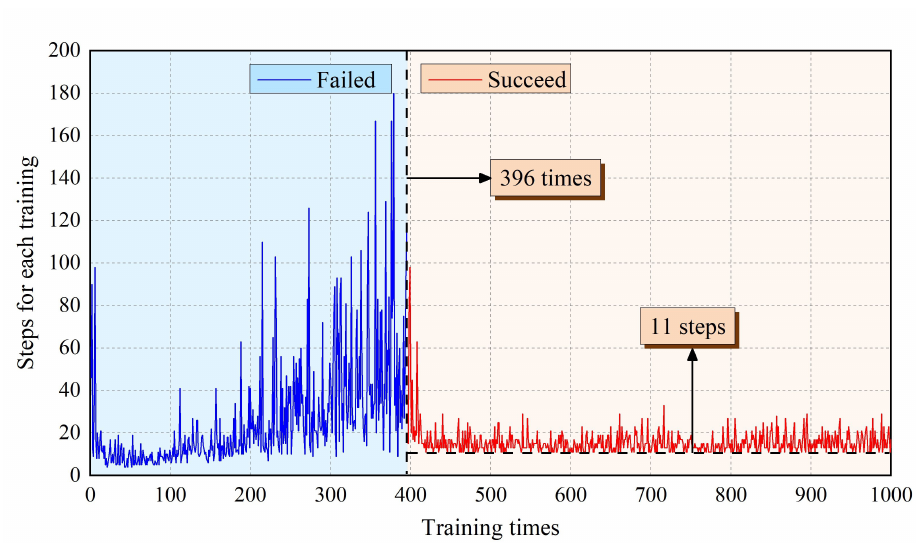
Figure 6. The number of steps of AstroLimbs for each training.